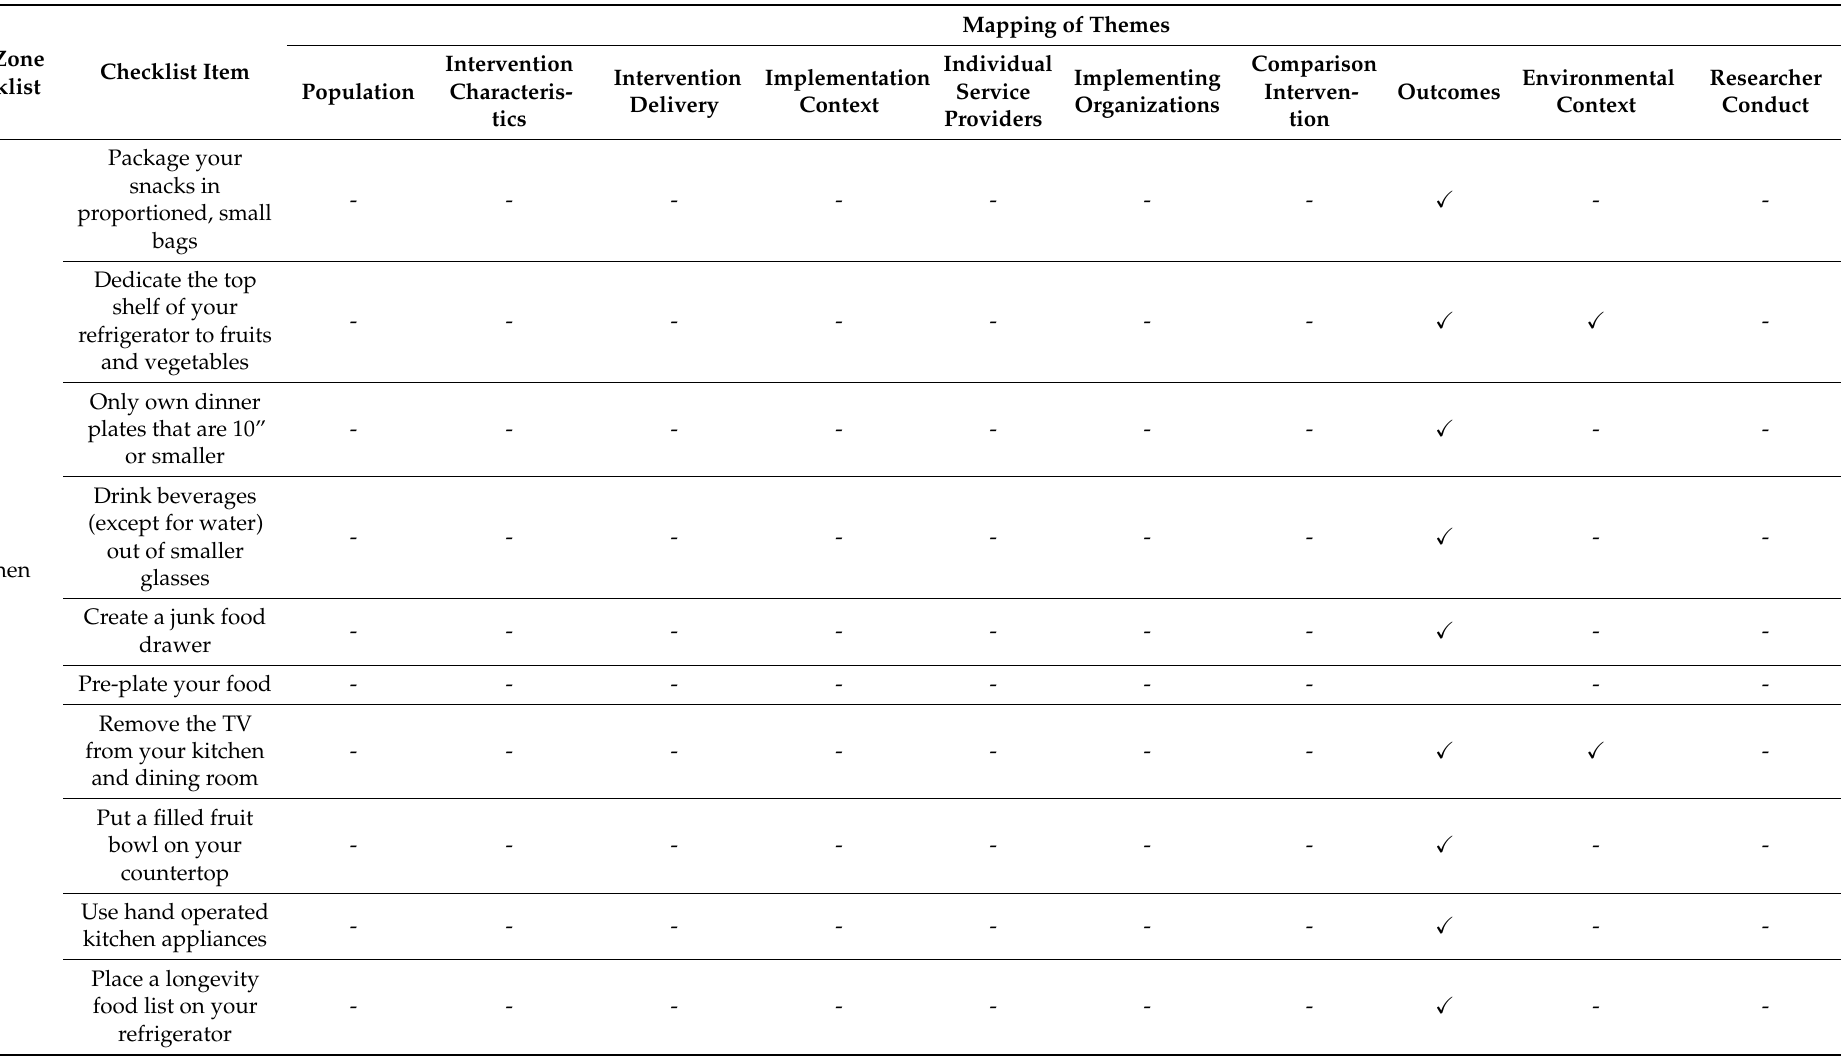
Table 9. Critical review of the “Kitchen” checklist based on the systematic mapping by Munthe-Kaas et al.